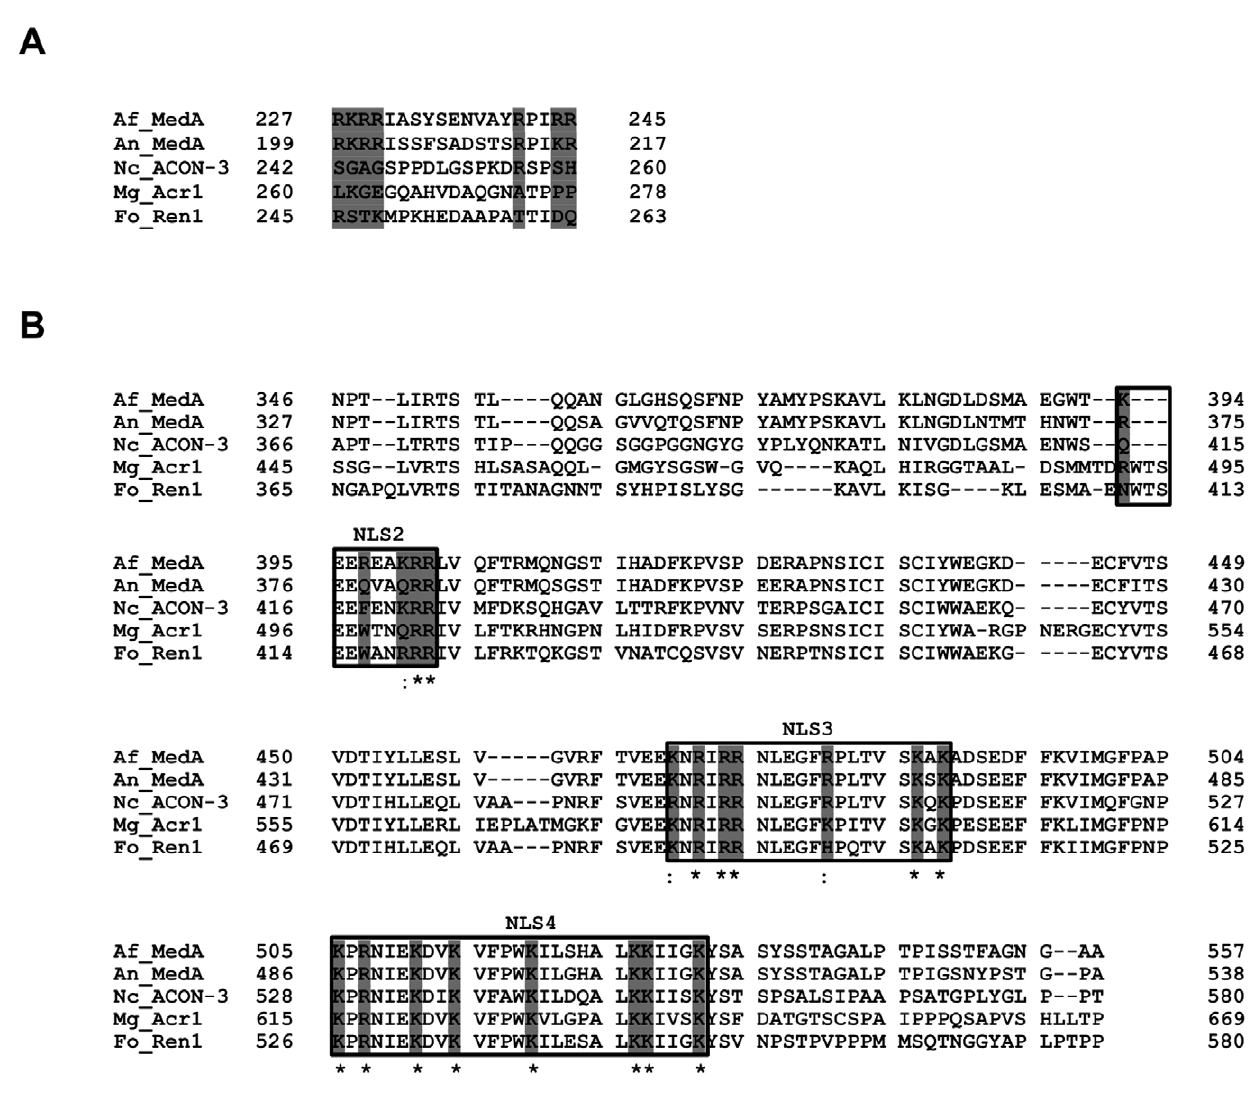
Figure 2. Amino acid sequence alignment of A.fumigatus MedA putative NLSs 1–4 with other MedA homologues. (A) Sequence alignment and motif prediction using PSORT II identified NLS1 sequence among orthologues of MedA. (B) Sequence alignment of the MedA minimal nuclear localization domain, MedA 346–557 with other MedA orthologues. The sequences representing the putative NLSs 2, 3, and 4 are boxed. The basic amino acids within the putative NLSs of A. fumigatus MedA and the corresponding amino acids in MedA orthologues are highlighted in gray. The presence of an asterisk or a colon below the basic amino acids indicates a fully or strongly conserved residue, respectively. Numbers indicate the amino acid position within the primary amino acid sequence of the protein. Af_MedA: A. fumigatus MedA (GenBank: EAL93620.1), An_MedA: A. nidulans MedA (GenBank: AAC31205.1), Nc_ACON-3: N. crassa ACON-3 (GenBank: ADL28820.1), Mg_Acr1: M. grisea Acr1 (GenBank: BAC41196.1), and Fo_Ren1: F. oxysporum Ren1 (GenBank: